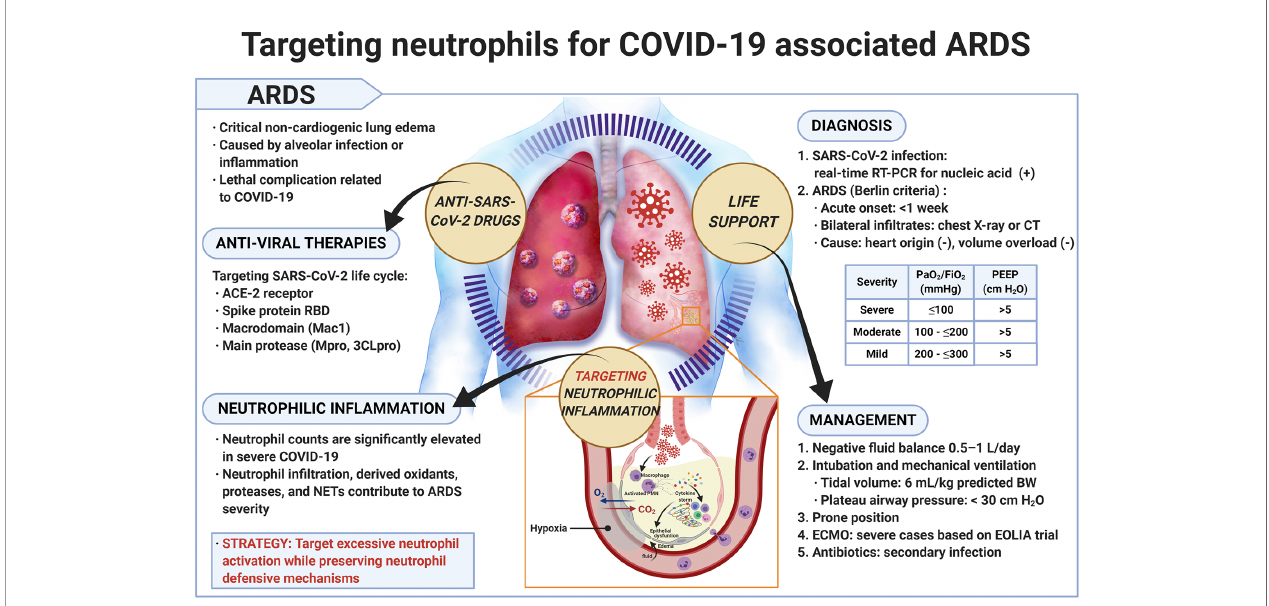
FIGURE 1 | Targeting neutrophils for COVID-19 associated ARDS. Precise diagnosis of SARS-CoV-2 infection and effective management of COVID-19 are important. Application of antiviral therapy together with suppression of overly active neutrophilic in fl ammation appears to be a promising strategy for treating patients with COVID-19 associated ARDS. ARDS, acute respiratory distress syndrome; BW, body weight; COVID-19, coronavirus disease 2019; CT, computed tomography; ECMO, extracorporeal membrane oxygenation; EOLIA, ECMO to rescue lung injury in severe ARDS; FiO 2 , inspired oxygen fraction; ACE2, angiotensin-converting enzyme 2; NET, neutrophil extracellular trap; PaO 2 , arterial oxygen tension; PEEP, positive end-expiratory pressure; PMN, polymorphonuclear leukocyte; RBD, receptor binding domain; RT-PCR, reverse transcription polymerase chain reaction; SARS-CoV-2, severe acute respiratory syndrome coronavirus